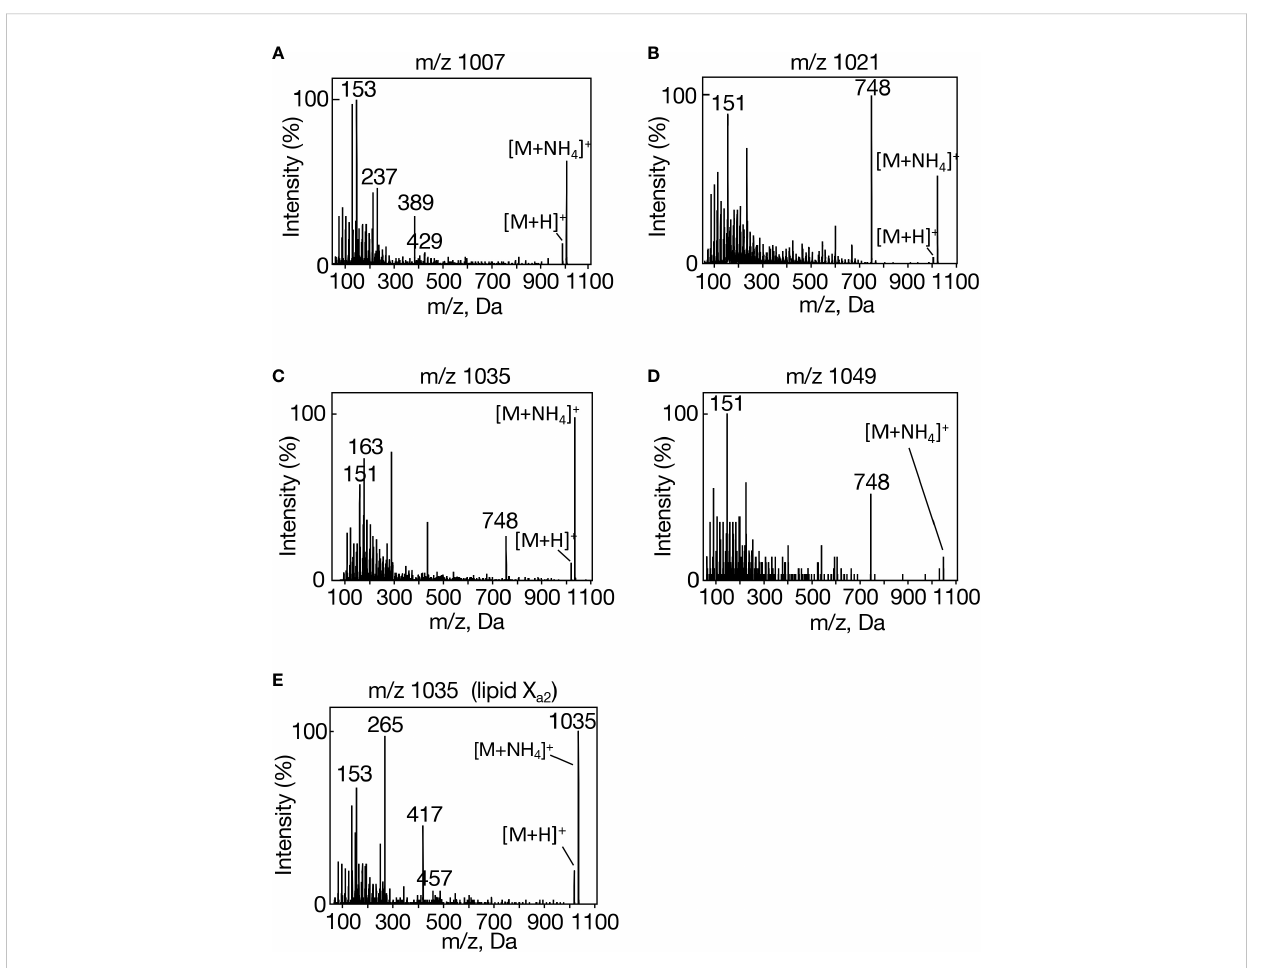
FIGURE 2 MS 2 spectra of individual lipid X molecular species in Synechocystis . (A) m/z 1007, (B) m/z 1021, (C) m/z 1035, and (D) m/z 1049 in aeration-cultured cells, and (E) m/z 1035 in statically cultured